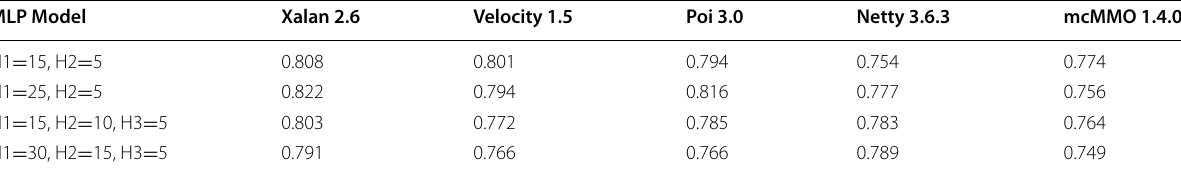
Table 8 ROC Area